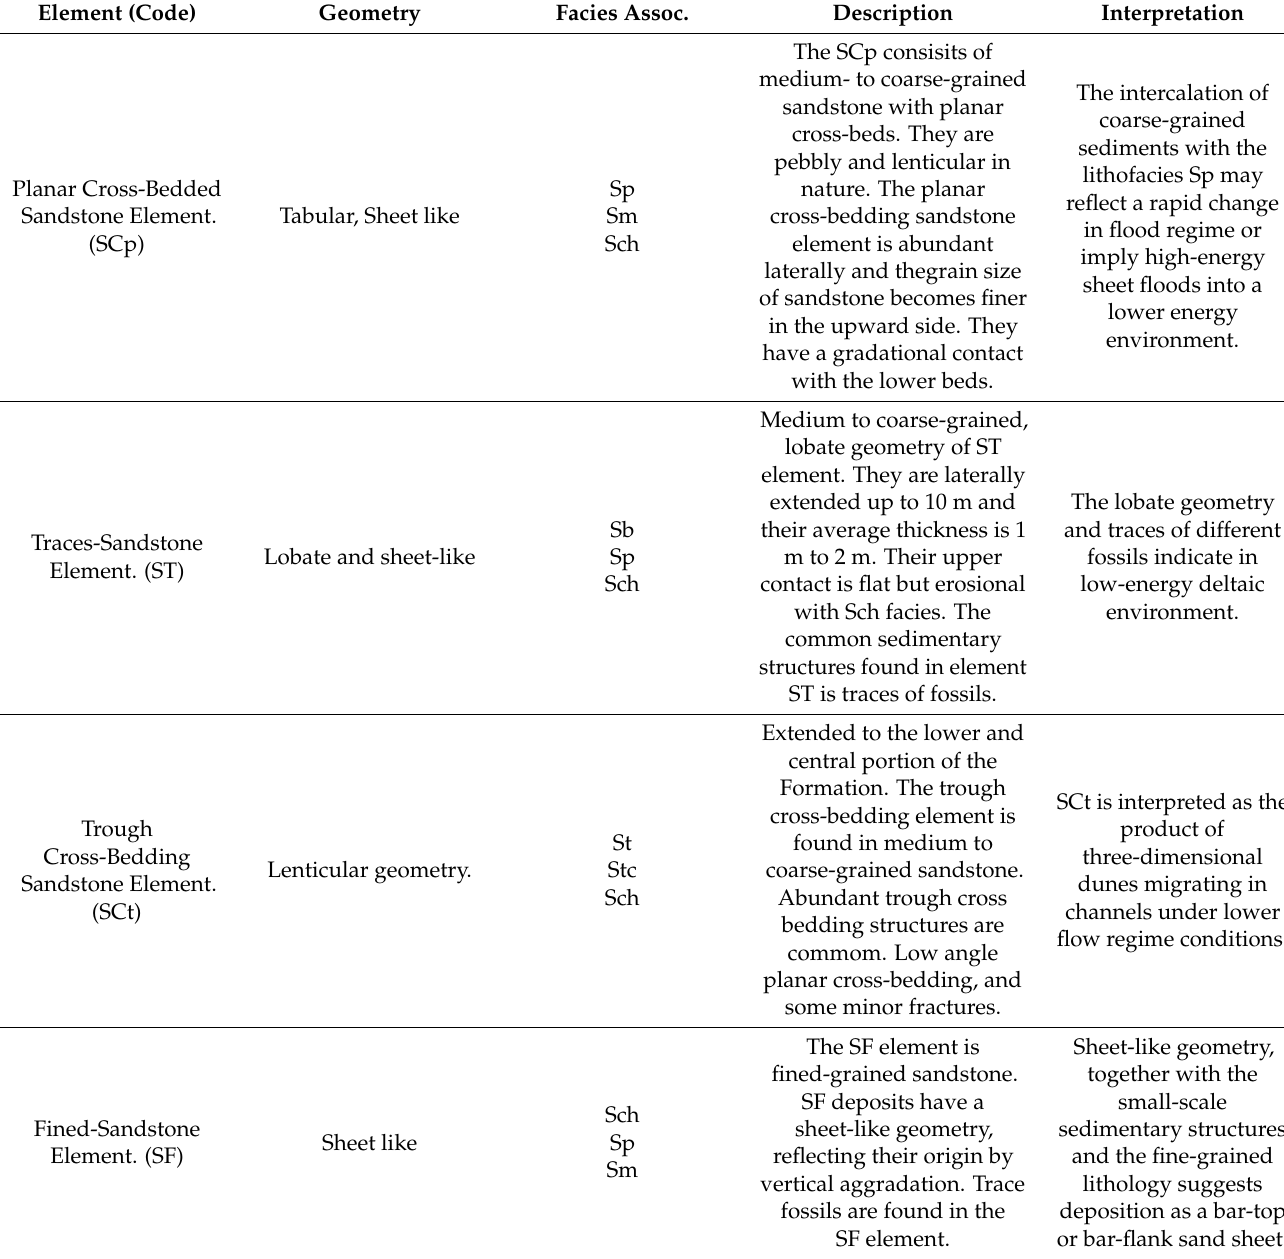
Table 2. Summary and generalized table of architectural element analysis from the studied area (Pab